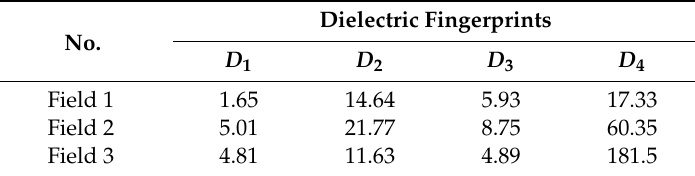
Table 12. Dielectric fingerprints of field